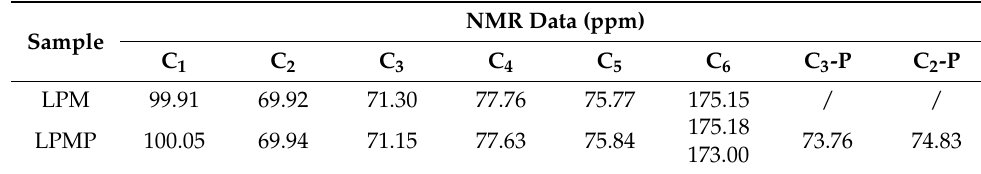
Figure 1. The characteristics of LPMP. ( A ) Chemical structure of LPMP. ( B ) IR spectra of LPM and LPMP. ( C ) The 13 C-NMR spectra of LPM and LPMP. ( D ) The 31 P-NMR spectra of LPMP. Table 1. The 13 C-NMR date of LPM and LPMP.